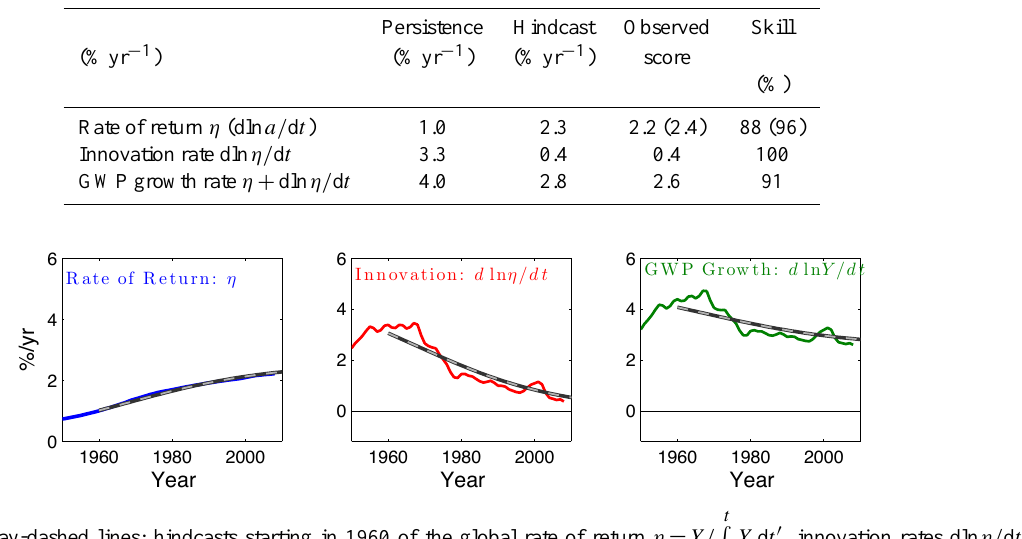
Figure 7. Black, gray-dashed lines: hindcasts starting in 1960 of the global rate of return η = Y/ the GWP growth rate dln Y/ d t = η + dln η/ d t . Hindcasts are derived from Eq. (16) assuming an average rate of technological change of 5.1%yr − 1 (dashed gray lines) derived from conditions observed in the 1950s. Solid colored lines: observed decadal running means. Hindcast values in 1960 represent persistence values shown in Table